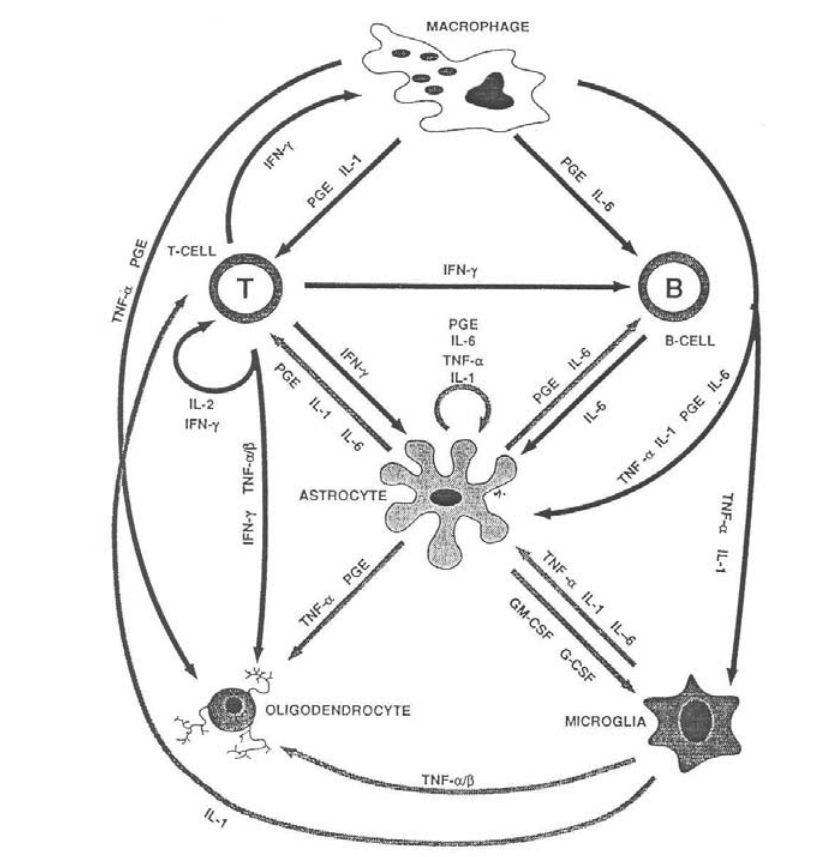
Figure 3: Potential interactions between cells of the immune system (T and B cells, and macrophages) and those of the central nervous system (astrocytes, microglia and oligodendrocytes). Solid arrow: cytokine effects mediated by immune system cells. Stippled arrows: cytokine effects mediated by nervous system cells. Adapted from Benveniste